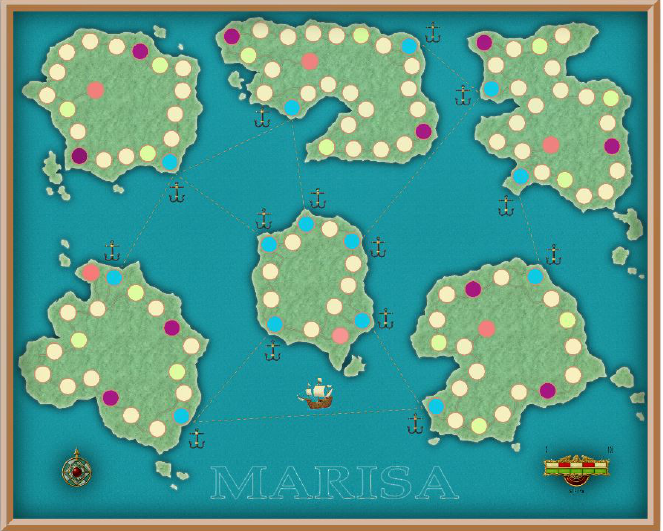
Figure 2. MARItime Surveillance knowledge Acquisition (MARISA) Game